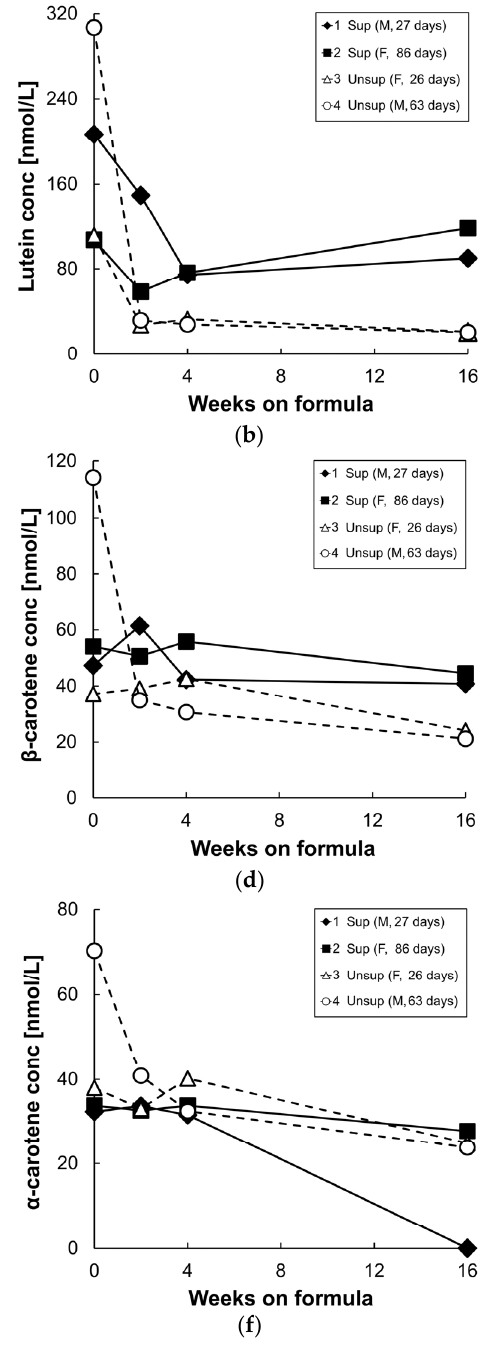
Figure 3. Plasma or serum total lycopene ( a ); lutein ( b ); zeaxanthin ( c ); β‐ carotene ( d ); β‐ cryptoxanthin ( e ); and α‐ carotene ( f ) concentrations of infant monkeys fed either supplemented formula ( n = 2) or unsupplemented formula ( n = 2) for 16 weeks. Each symbol represents one animal; solid symbol and solid line denote supplemented formula (Sup) while open symbol and dotted line denote unsupplemented formula (Unsup).